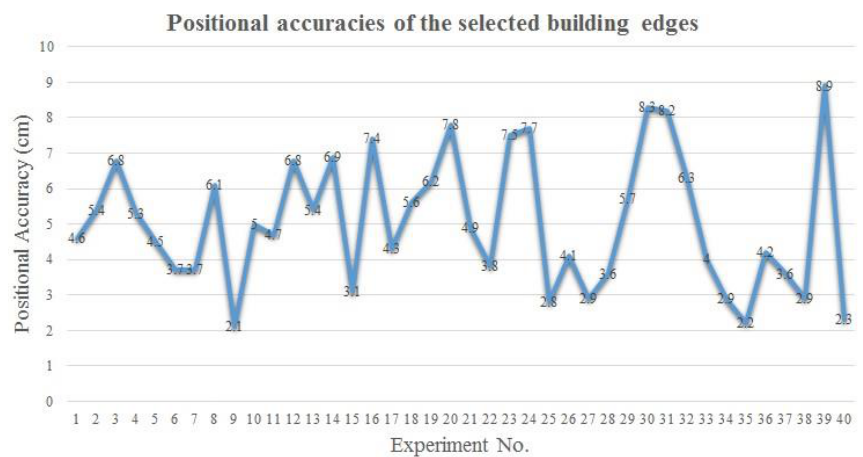
Figure 10. A quantitatively comparative distance results between the extracted building edges and their references.